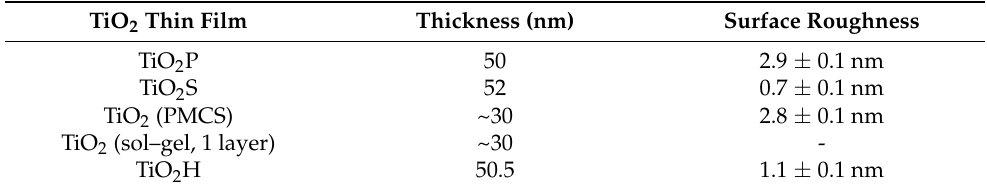
Table 1. Properties of the three types of TiO 2 thin films . In the case of TiO 2 H, we also report properties of the two single layers from PMCS and sol–gel methods composing the film.